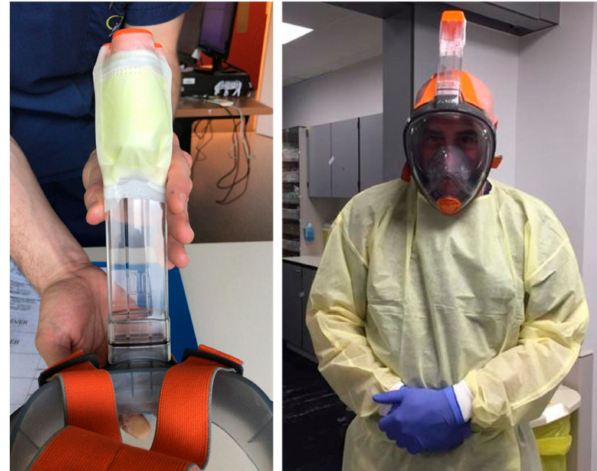
Figure 1. Snorkel mask configurations tested. See Table 1 for details. Lower right: ‘full face’ assembly with FFP2 mask (3M Aura 9322 + ), protection goggles and face shield, for size comparison.